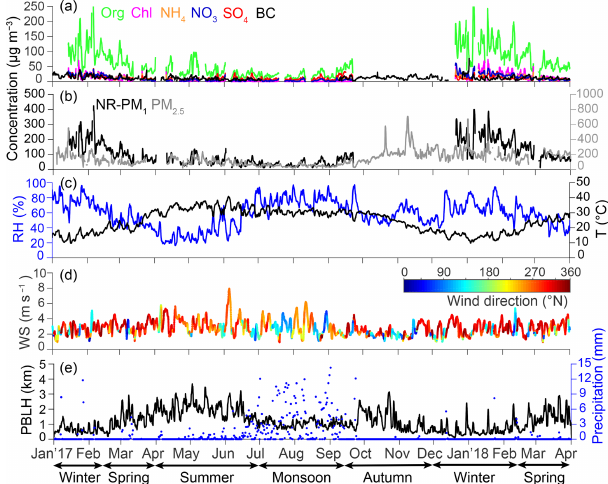
Figure 2. Time series of (a) PM 1 species (Org, Chl, NH 4 , NO 3 , SO 4 , and BC), (b) NR-PM 1 and PM 2 . 5 (DPCC, R.K. Puram – 3km from our site), (c) relative humidity and temperature, (d) wind speed and direction, and (e) PBLH and precipitation. A 24h moving aver- age is applied on all time series presented.